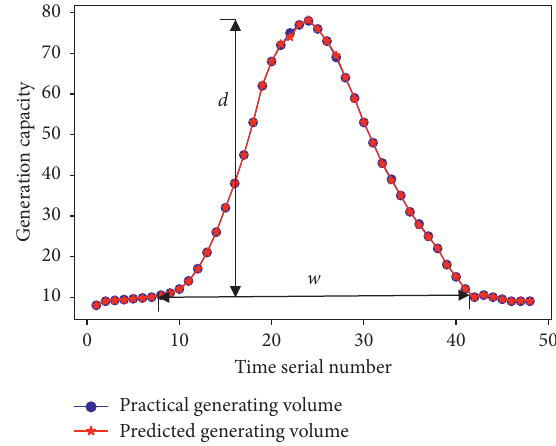
Figure 6: Forecast of one-day power generation in